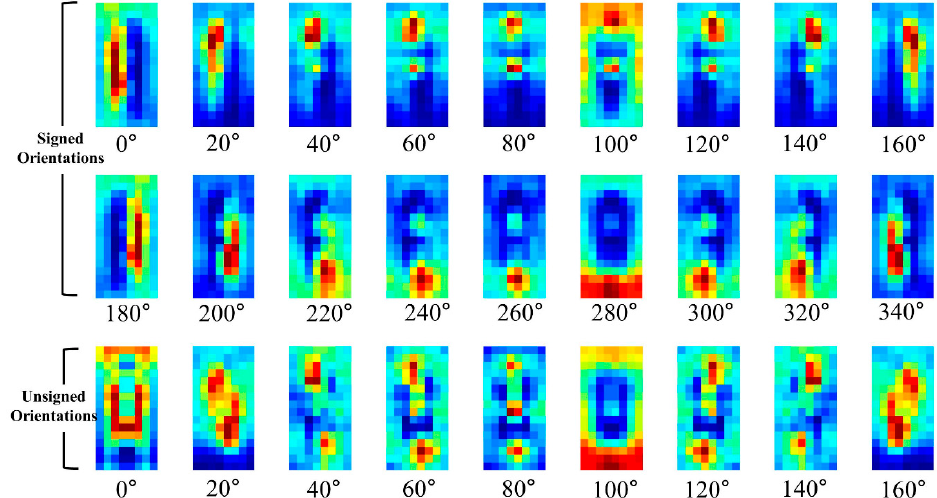
Figure 8. Average gradient channels of HOG for pedestrians.